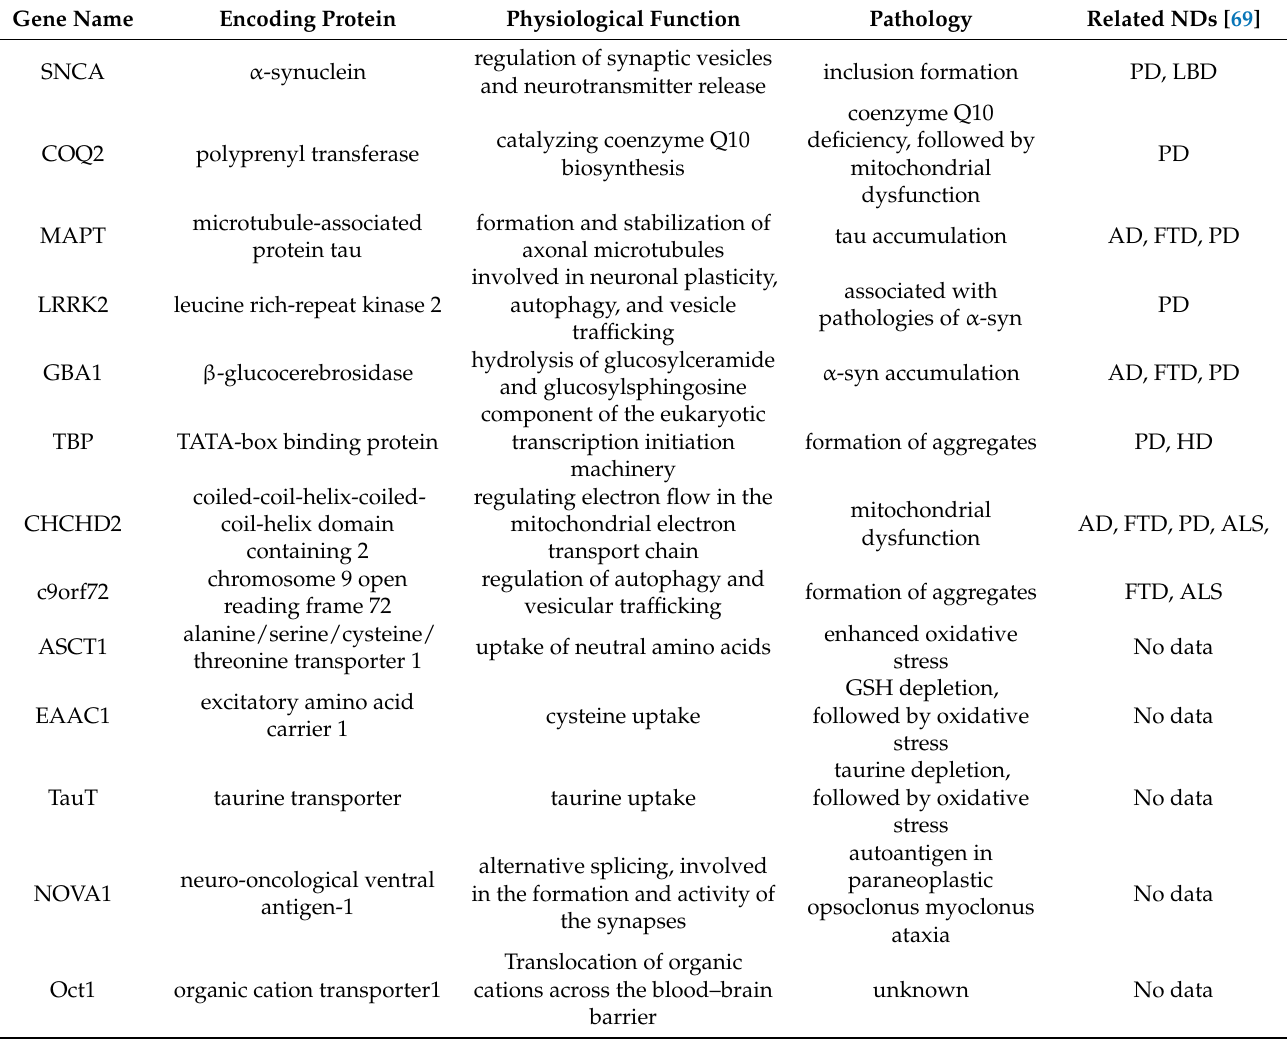
Table 1. List of genes that are mutated and/or altered in